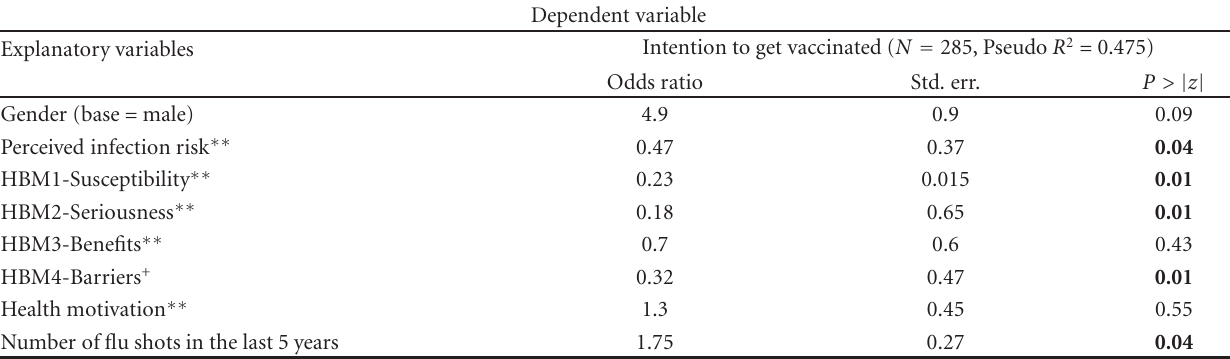
Table 6: Results of logistic regression for dependent variables: intention to get